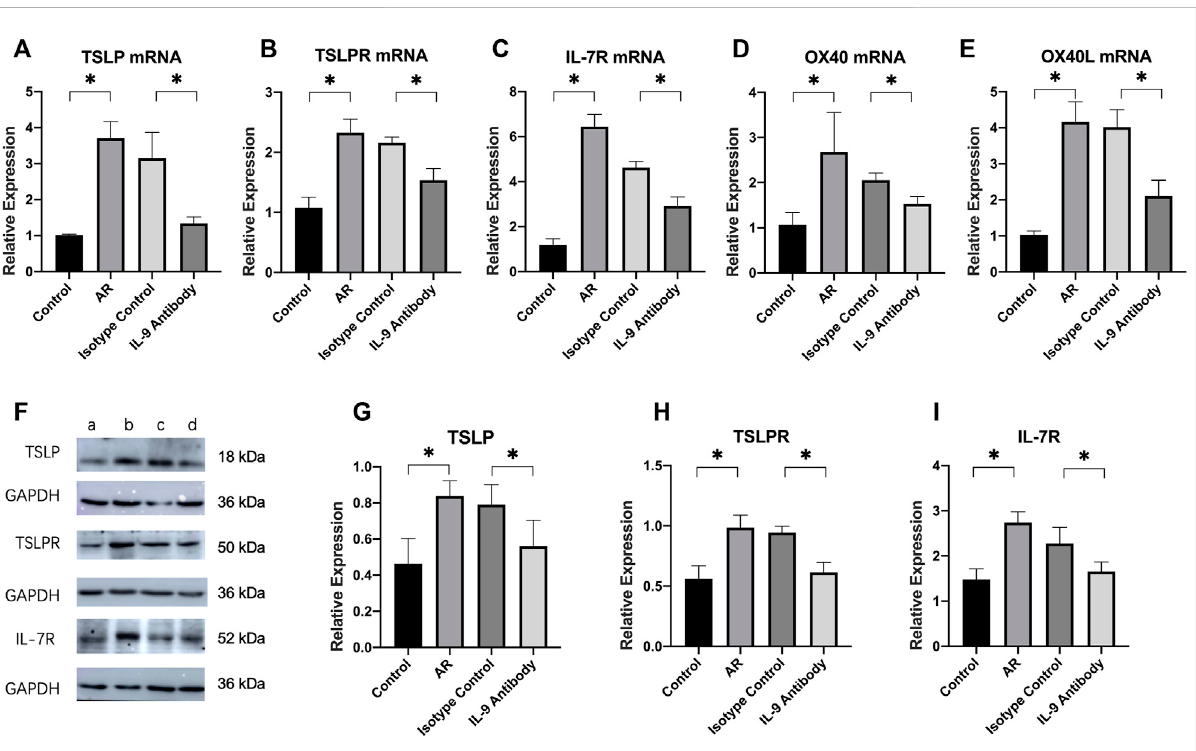
FIGURE 4 Expression of TSLP pathway and their mRNA in nasal mucosa of mice in each group. (A) – (E) Real-time PCR was used to detect the mRNA expressions levels of TSLP, TSLPR, IL-7R, OX40, and OX40L innasal mucosa. Weused 2 − ΔΔ Ct to calculate therelativeexpressions. We used β -actin as the internal control. Each group repeats fi ve independent samples, and each independent sample repeats three times to take the mean value. One way ANOVA/Tukey was used for statistical analysis. All results were mean ± SEM. * p < 0.05. (F) Western blot analysis for TSLP, TSLPR, IL-7R in nasal mucosa. Each lane contains 30 μ g of protein. Protein expression was normalized to GAPDH. a was thecontrol group, b was theallergicrhinitis group, cwas IL-9 neutralizing antibody group and d was thehomotypic control group. Each lane is a representation of fi ve independent